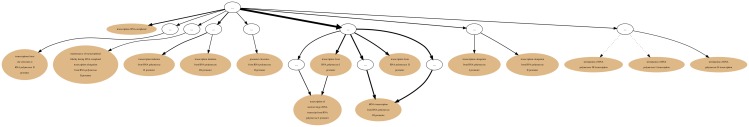
Complex 3 Set annotation graph re-rooted at the RNA biosynthetic process term.Annotation graph of the Complex 3 (YHTP2008 Collection) Set for the GO biological process sub-ontology re-rooted at the RNA biosynthetic process term.